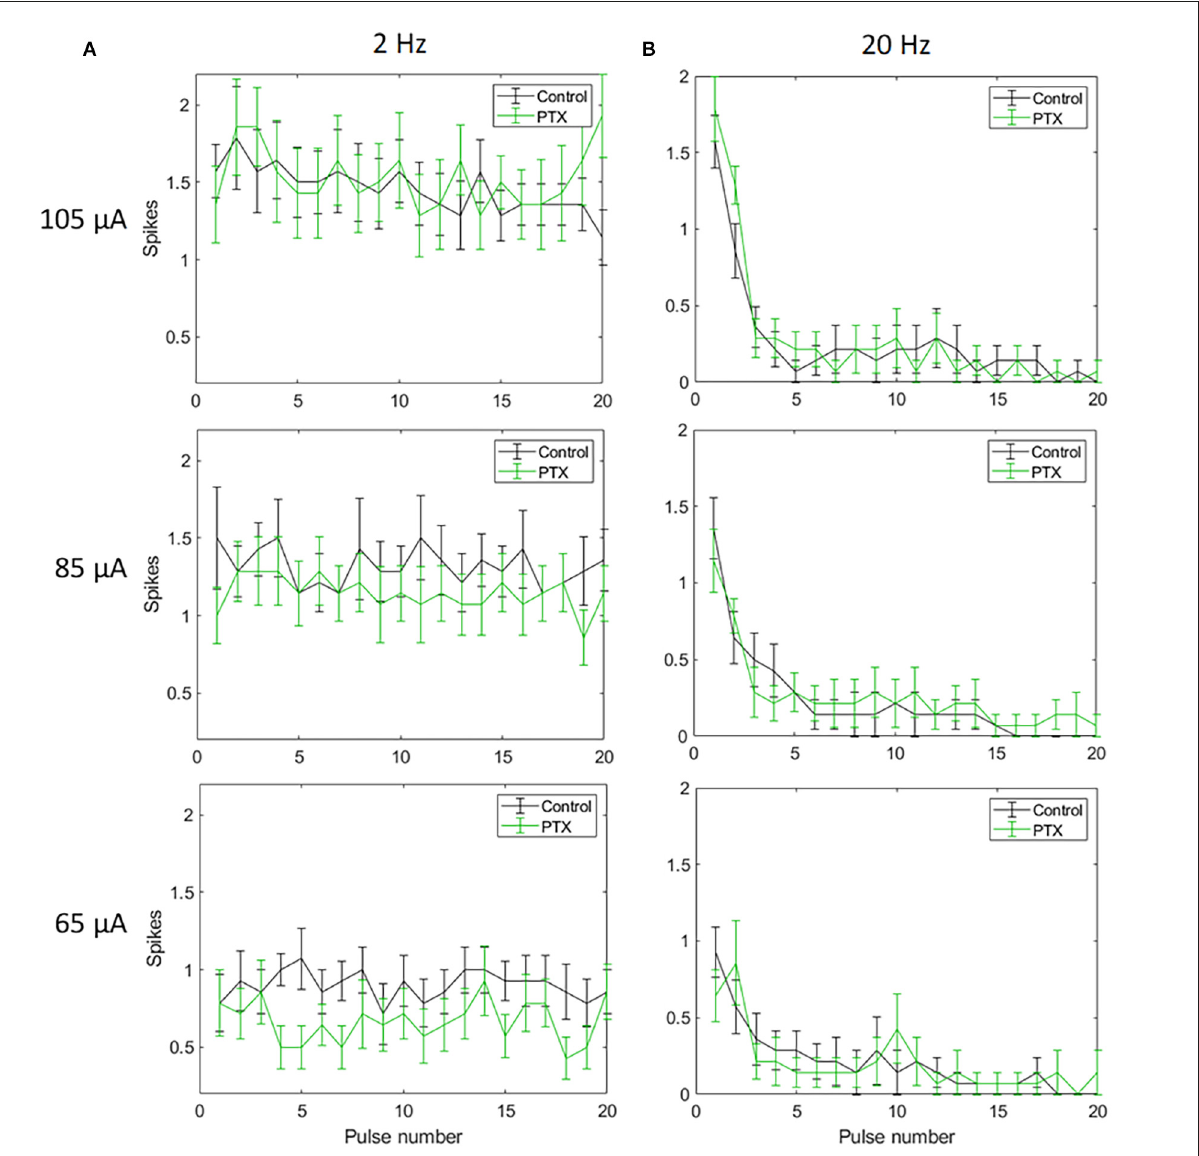
FIGURE4 The effect of PTX on RGC spiking ( n = 14) at different current amplitudes for stimulation delivered at 2 Hz (A) and 20 Hz (B) . The average numbers of RGC spikes in response to 20 pulses delivered at three current amplitudes (65 µ A, 85 µ A, and 105 µ A) are shown in each figure. Evoked spikes are counted in 5 ms bins after the onset of each pulse. Error bars show the standard error of the mean